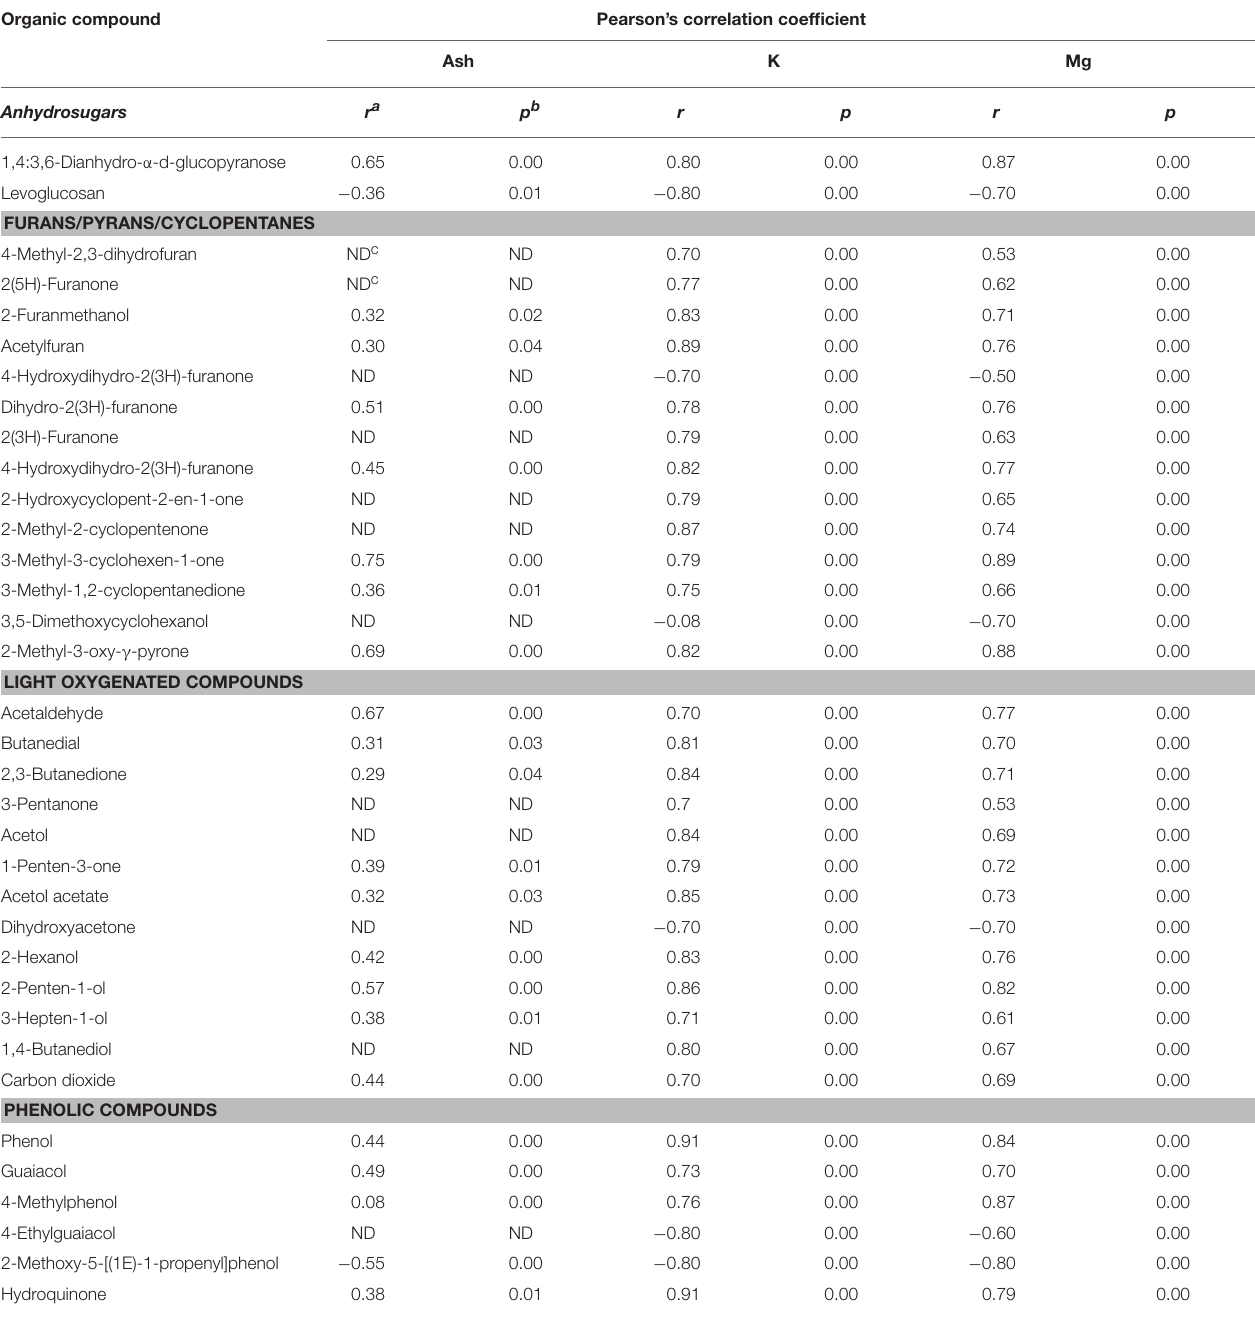
TABLE 3 | Pearson’s correlation between inorganic compounds in the unextracted and extracted switchgrass samples and the pyrolytic organic compounds produced by Py-GC/MS. Organic compound Pearson’s correlation